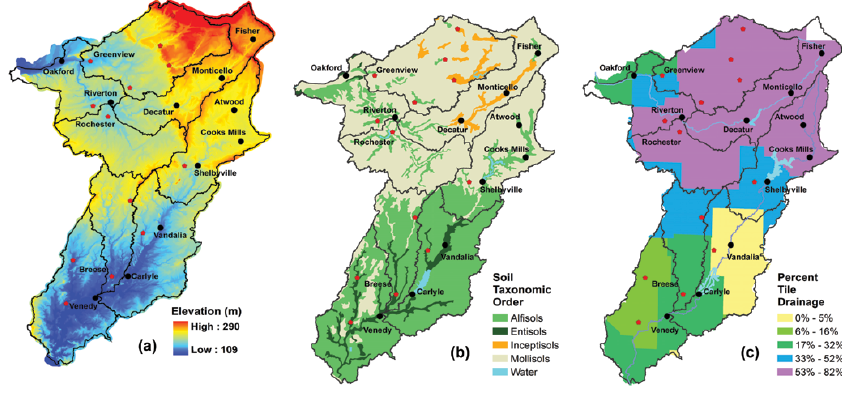
Fig. 3. USGS topography (a) , STATSGO soil taxonomy (b) , and WRI estimates of percent tile drainage by county (c) .